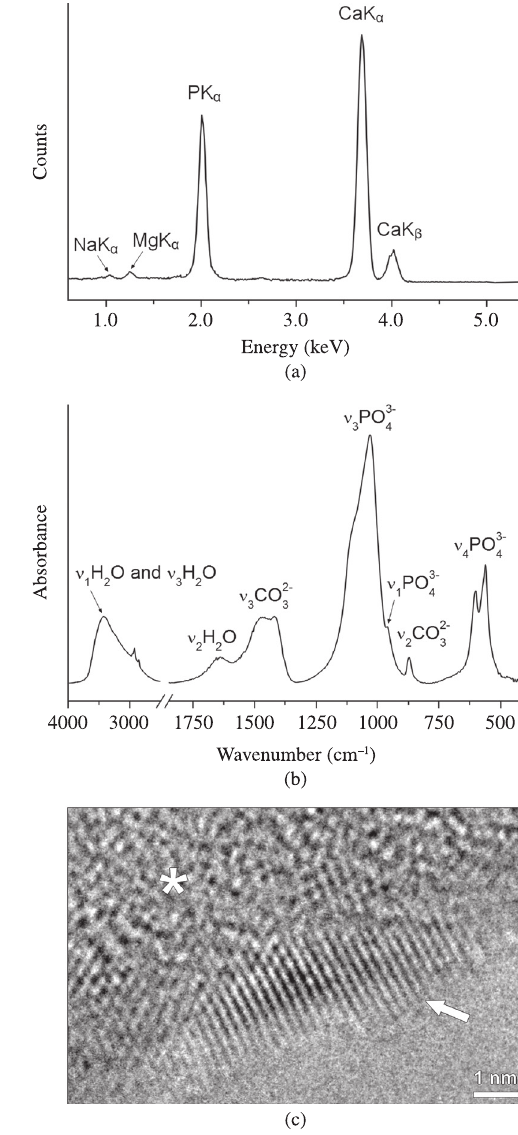
Figure 1. General characterization of the mineral sample. (a) EDS spectrum. Ca and P were main components of the mineral. (b) FTIR spectrum. The mineral was identified as a poorly crystalline, CO 32– -containing apatite. (c) HRTEM micrograph. The mineral comprised both nanocrystalline particles (arrow) and amorphous materials (asterisk).